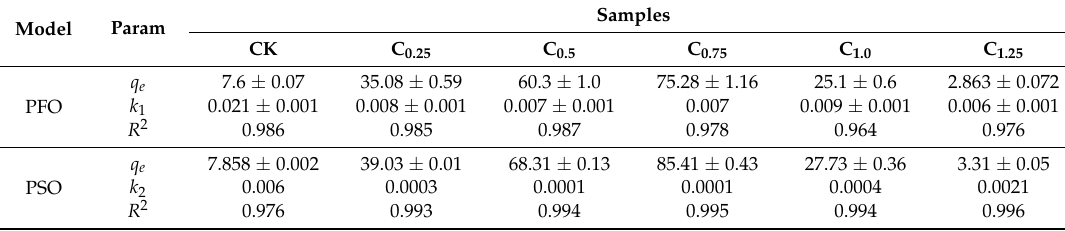
Table 4. Estimated kinetic model constants for Cd (II) adsorption. PFO: Pseudo-first-order; PSO: Pseudo-second-order.